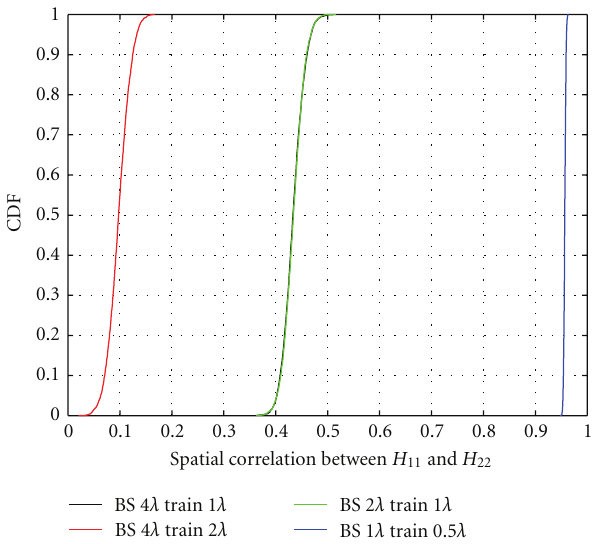
Figure 4: The space correlation in terrain